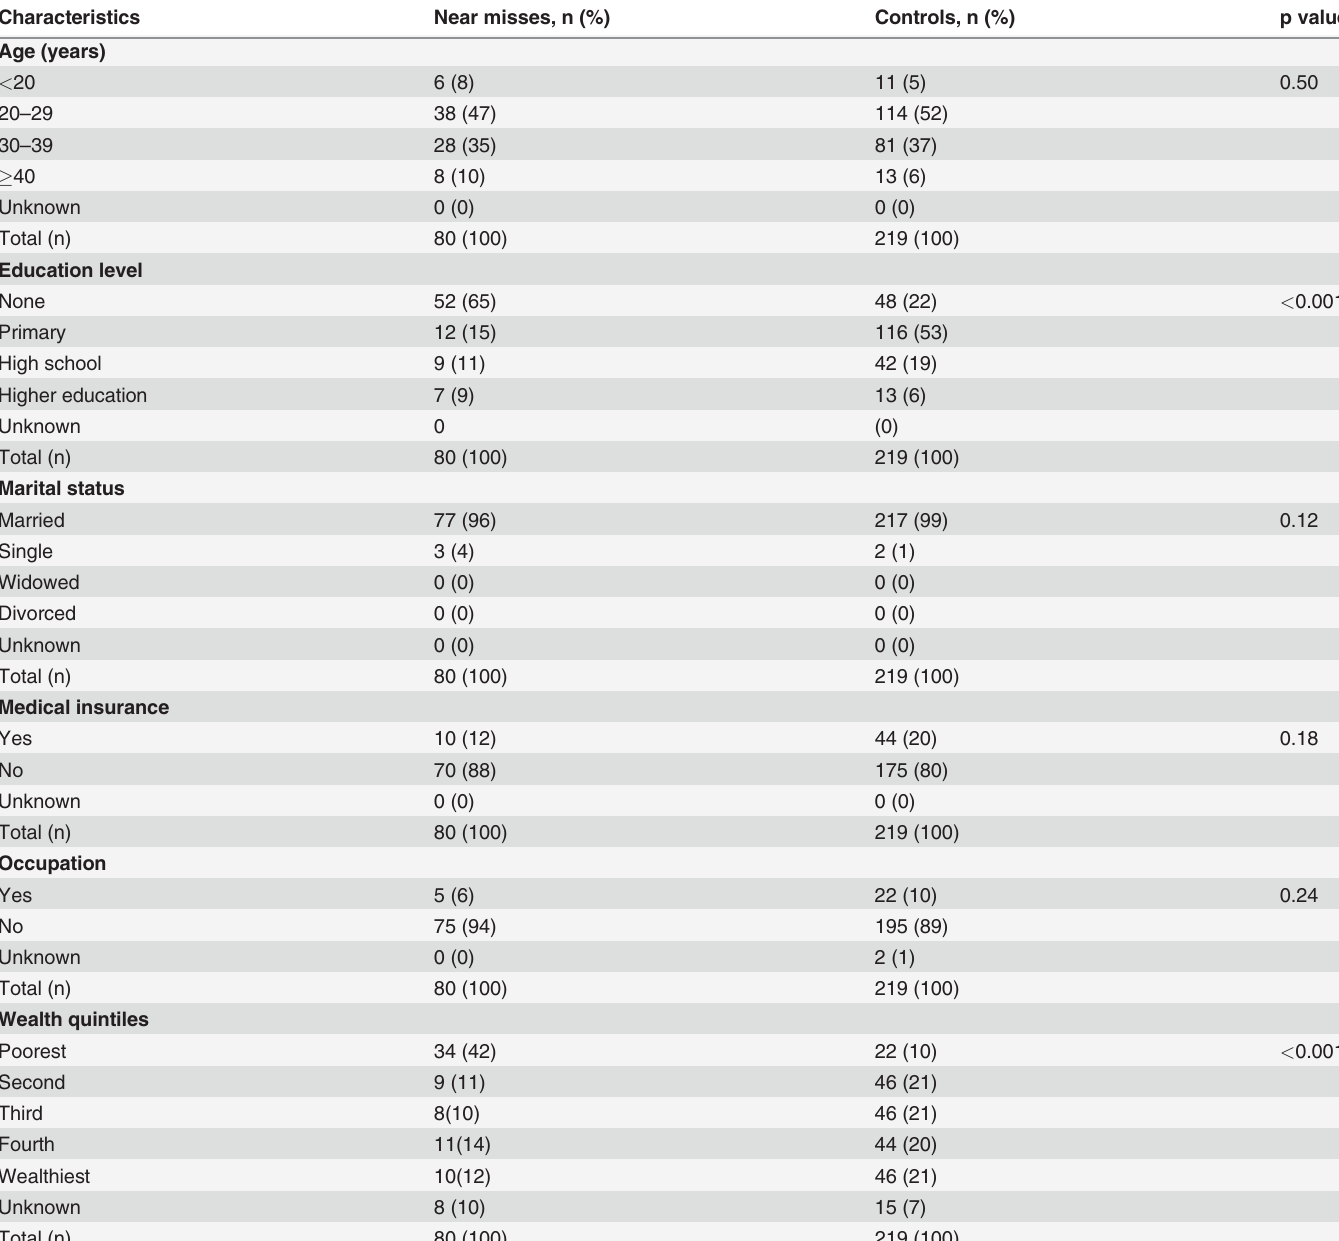
Table 1. Comparison of demographic characteristics.